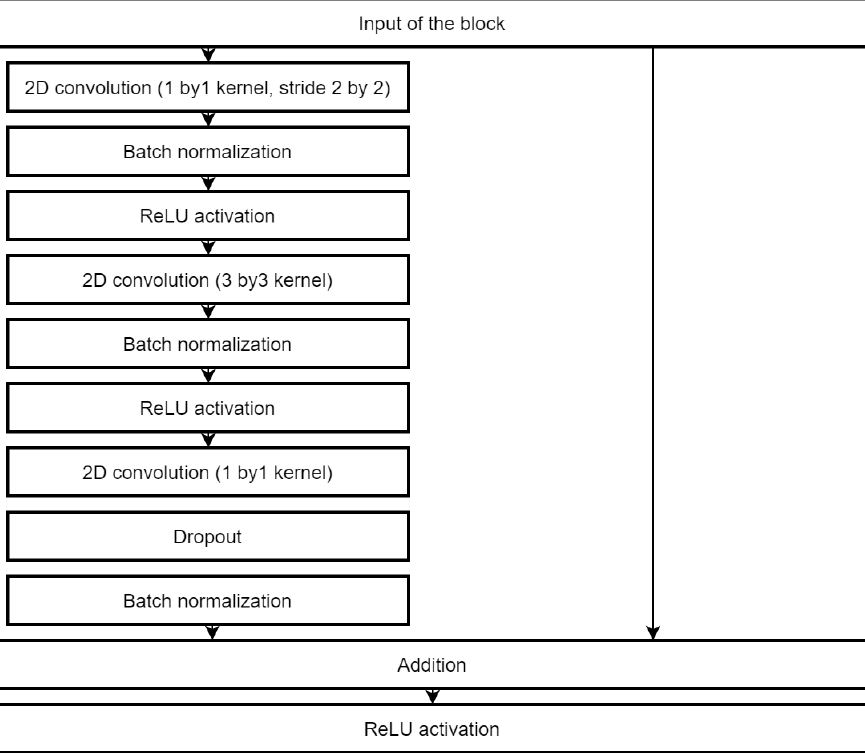
Figure 6. The convolution identity block used in the main classification